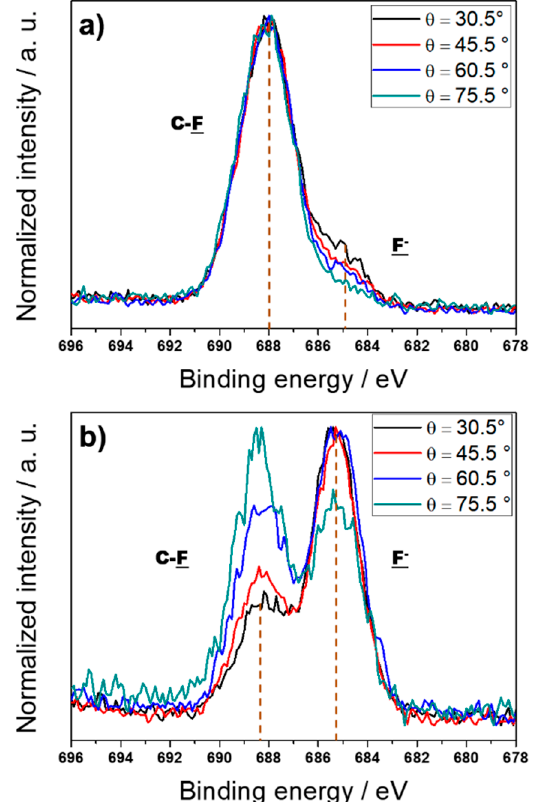
Figure 5. F1s XP-high resolution regions of ZnO-CF x nanocomposites having an inorganic phase volume fraction of φ = 0.15 as a function of θ and subject to thermal treatment in an oxygenated atmosphere ( a ) or deposited with an auxiliary O 2 flow ( b ).